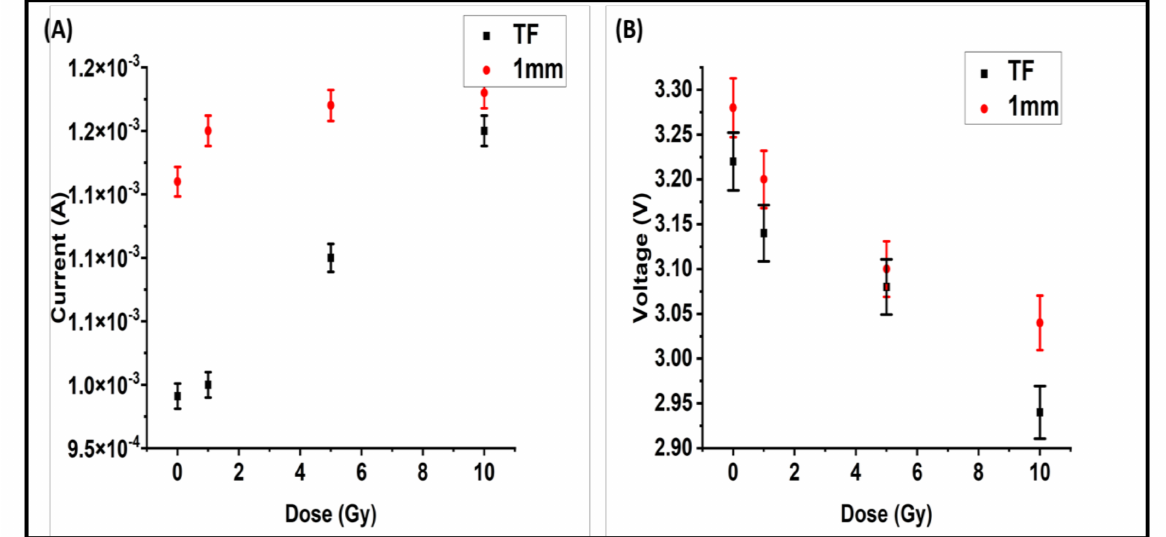
Figure 8. ( A ) Voltage vs. dose and ( B ) current vs. dose for the thin film and disk